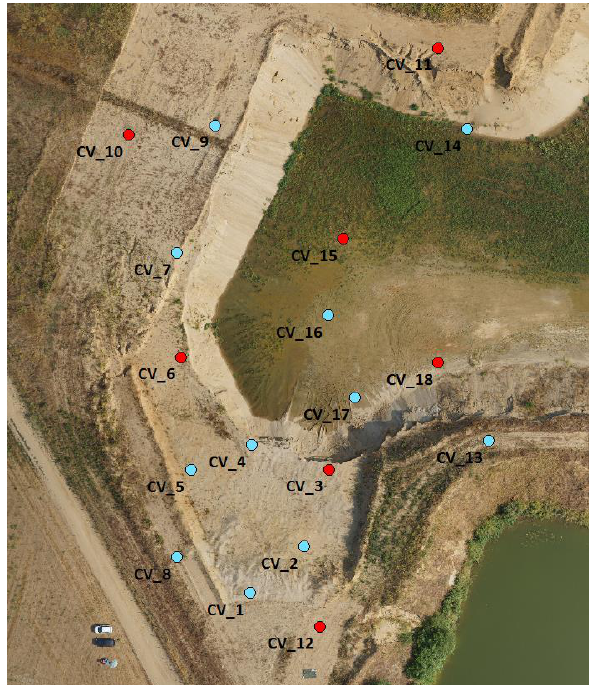
Figure 6. Location of the signalized points. Red dots were used as GCPs and blue ones as CKPs